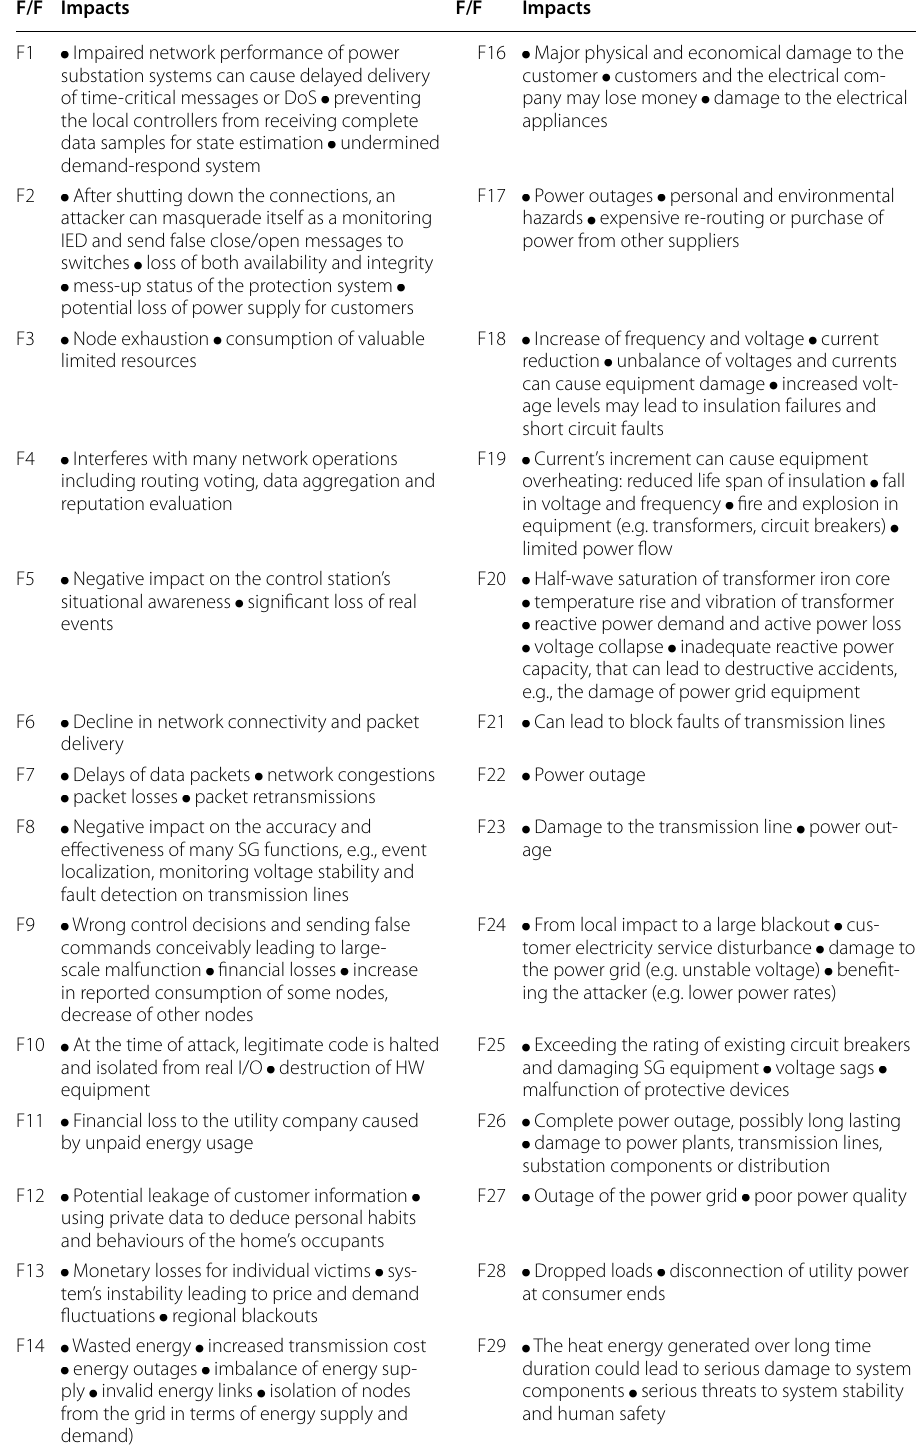
Table 4 RQ4 (Impacts of found faults and failures) F/F